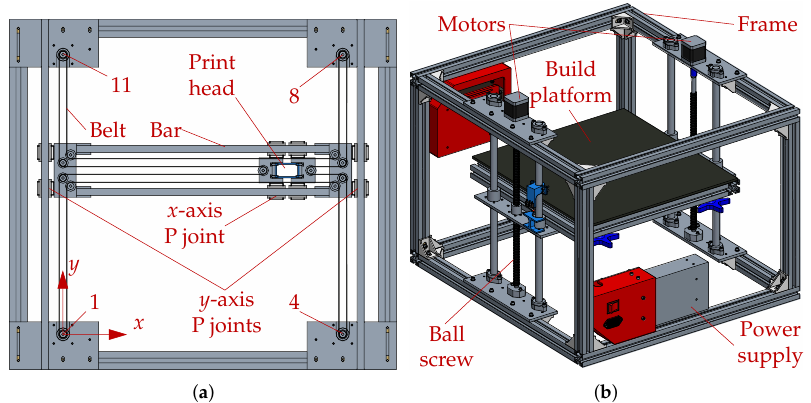
Figure 10. ( a ): The CoreH-bot belt routing, from our CAD model (section view from below). ( b ): The printer frame and the mechanism for z -axis motion; the belt routing is not shown here, for clarity. with respect to W ). The torque in Eq. (37), on the other hand, is variable : at a minimum, it + x P = 1 is equal to zero when x = 1 x P W , namely when the EE is moving along the 2 2 2 3 vertical axis of symmetry of the workspace. The maximum absolute value of the torque in (cid:0) (cid:1) Eq. (37) is close to 2 ∆ TW , which is reached when the EE is moving close to the left or the right edge of the RW defined in Eq. (20); notice that this torque will be in fact smaller than